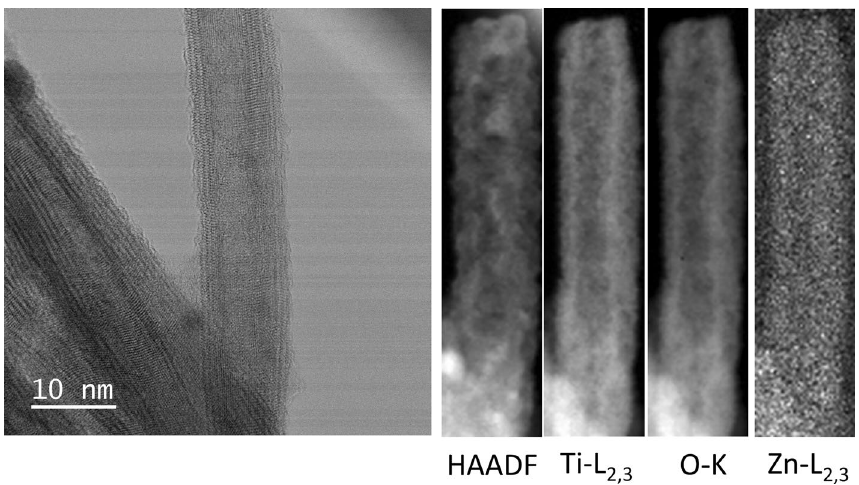
Figure 4. STEM and electron energy loss spectroscopy (EELS) of T2. From left to right, bright field (BF- obtained prior to carrying out the EELS acquisition), high-angle annular dark-field (HAADF); Ti-L 2,3 , O- K and Zn-L 2,3 .